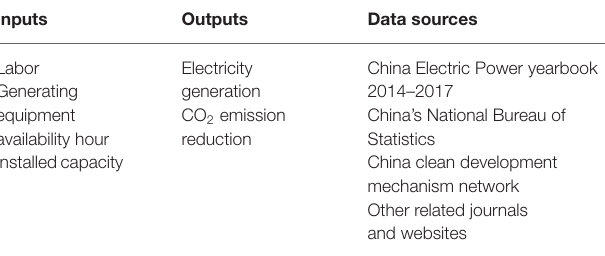
TABLE 1 | Input and output